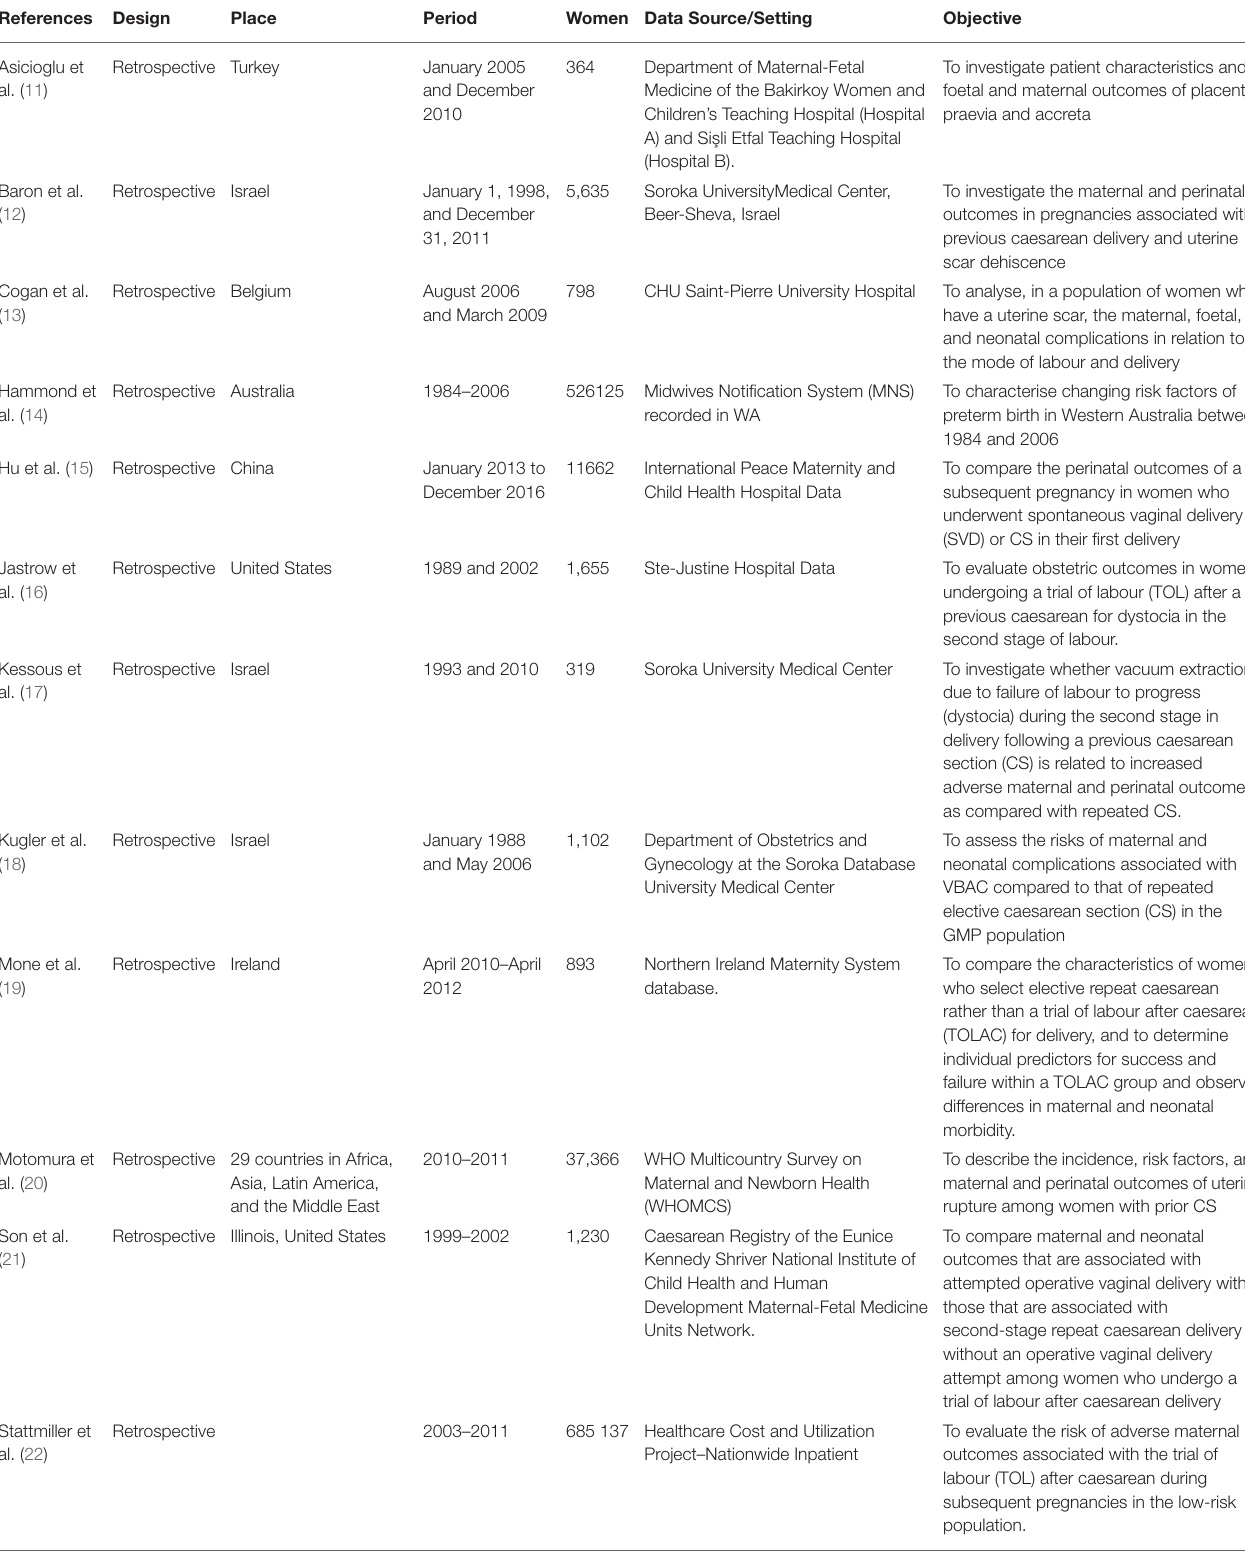
TABLE 1 | Characteristics of studies included to find the correlation between previous caesarean section and adverse maternal